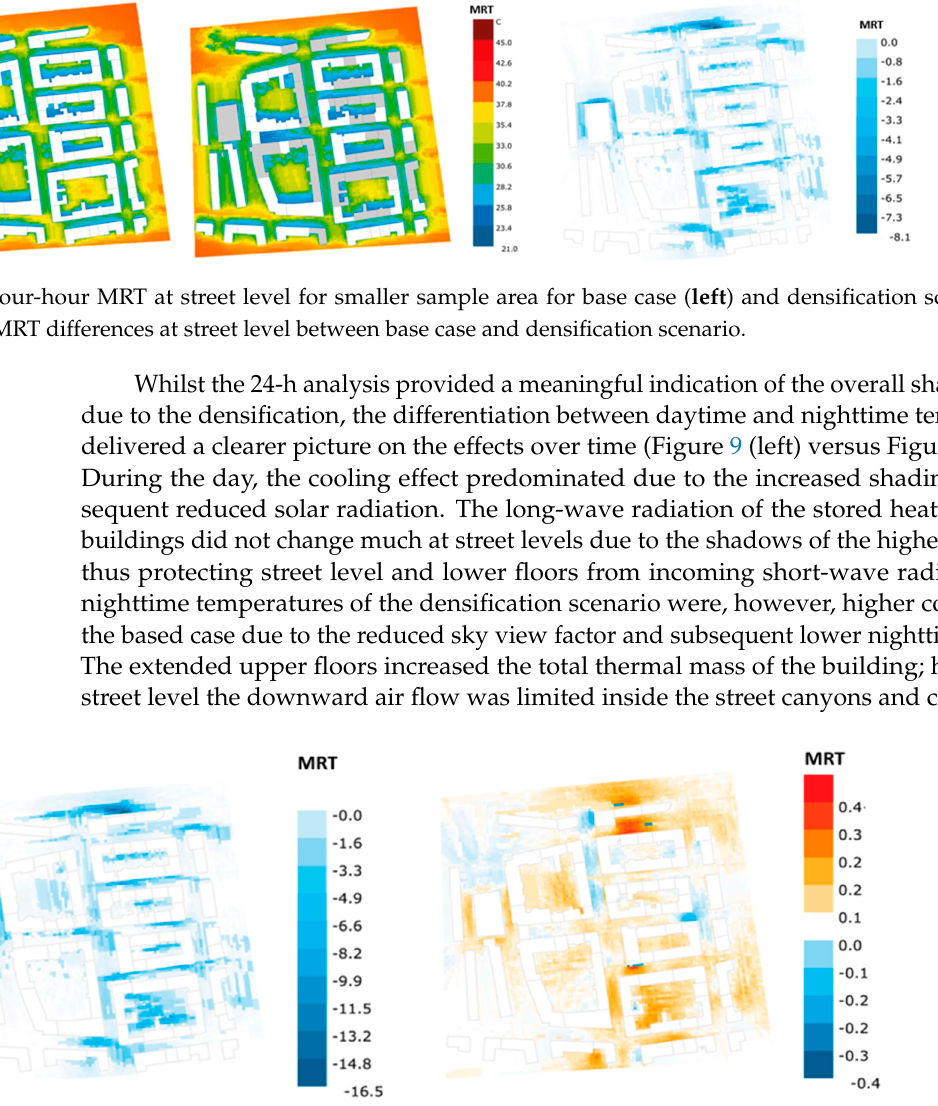
Figure 9. Twelve-hour MRT differences at street level between base case and densification sce- nario for smaller sample area for daytime ( left ) and nighttime ( right ).